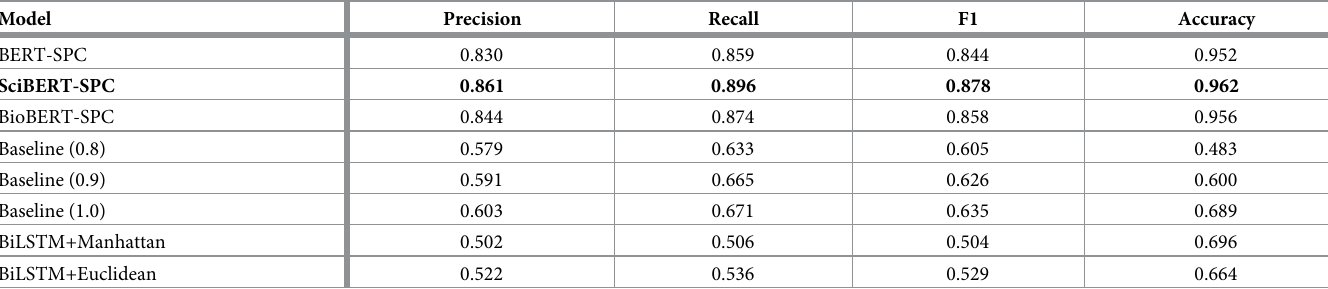
Table 4. RRID-linking performance comparison.